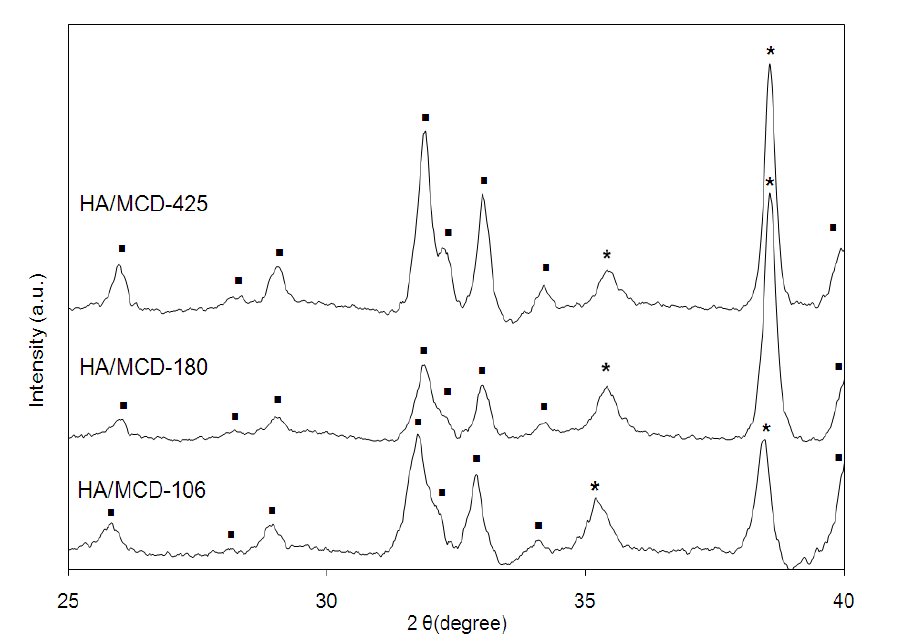
Figure 5. XRD of the